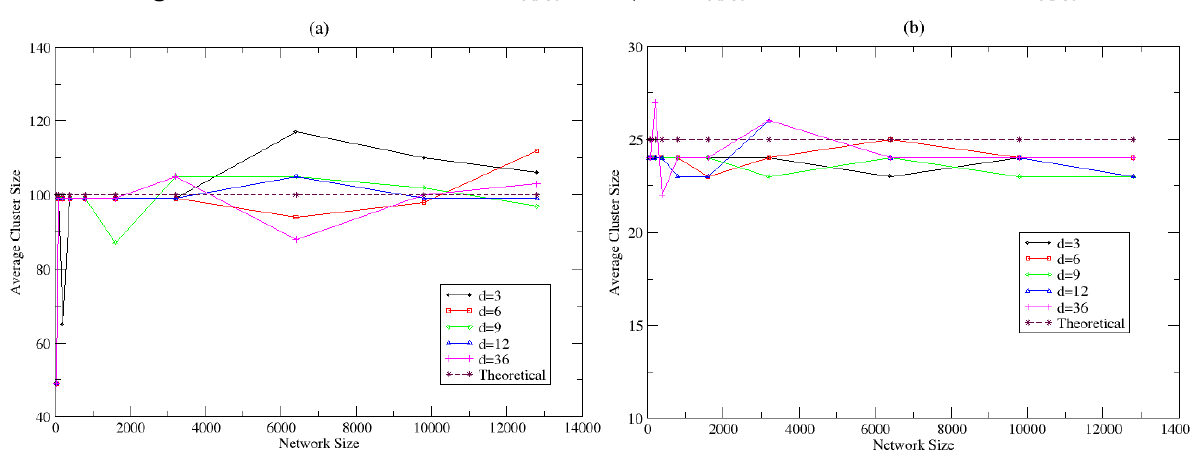
Figure 14. Cluster Size for (a) P